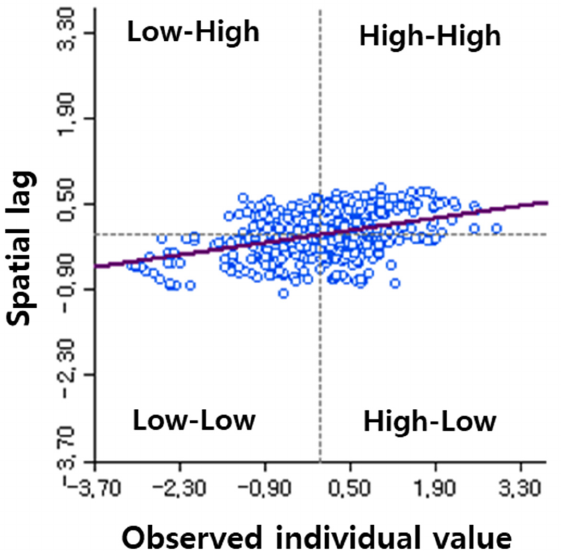
Figure 2. An example of a scatter plot with local indicators of spatial autocorrelation (LISA) applied. The X -axis and Y -axis indicate the observed value of each individual and spatial lag calculated by Equation (1), respectively.